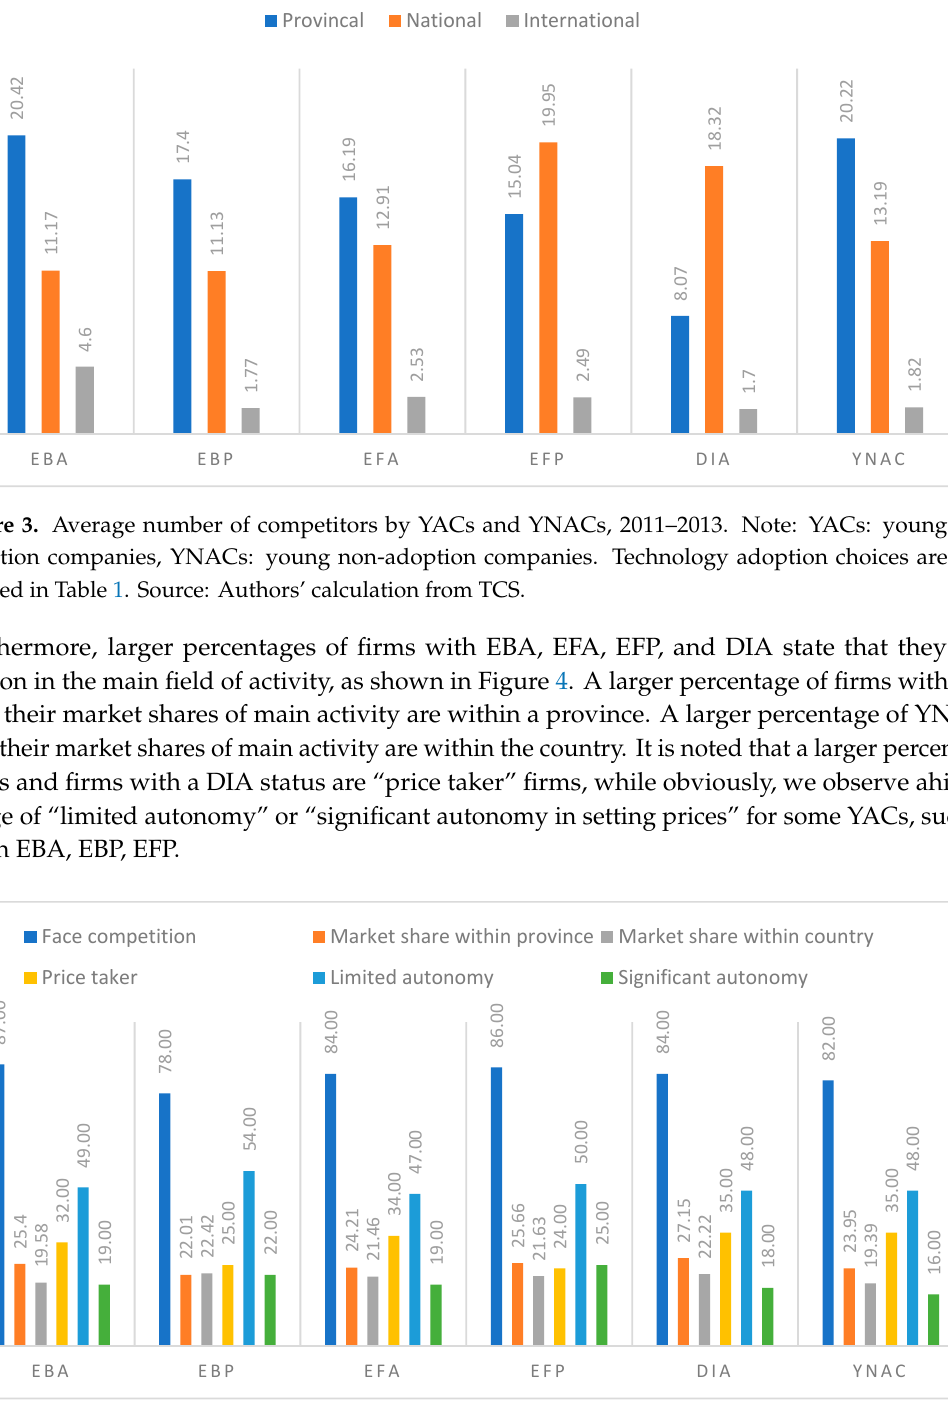
Figure 4. Competition and firms’ market power by YACs and YNACs; average percentage over 2011–2013. Note: YACs: young adoption companies, YNACs: young non-adoption companies. Technology adoption choices are defined in Table 1. Source: Authors’ calculation from TCS .